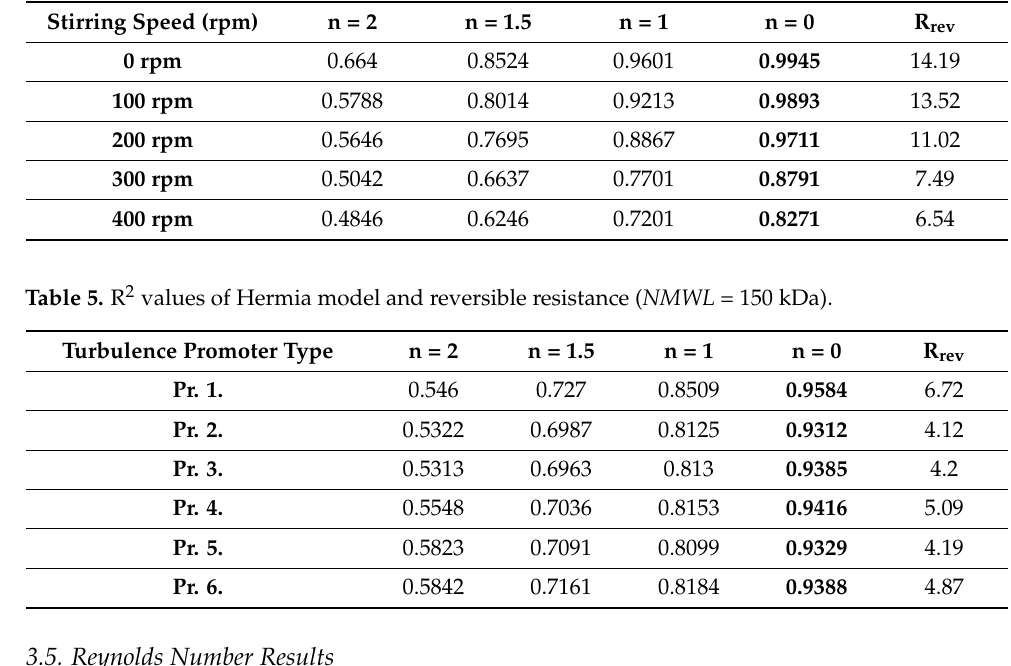
Table 4. R 2 values of Hermia model and reversible resistance ( NMWL = 150 kDa).